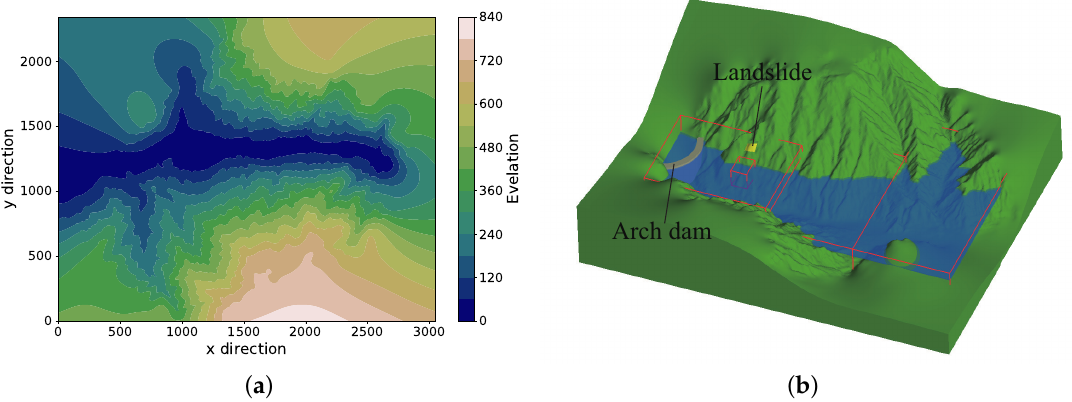
Figure 9. Large-scale numerical model of Laxiwa Reservoir, China. ( a ) Laxiwa terrain. ( b ) Geometric